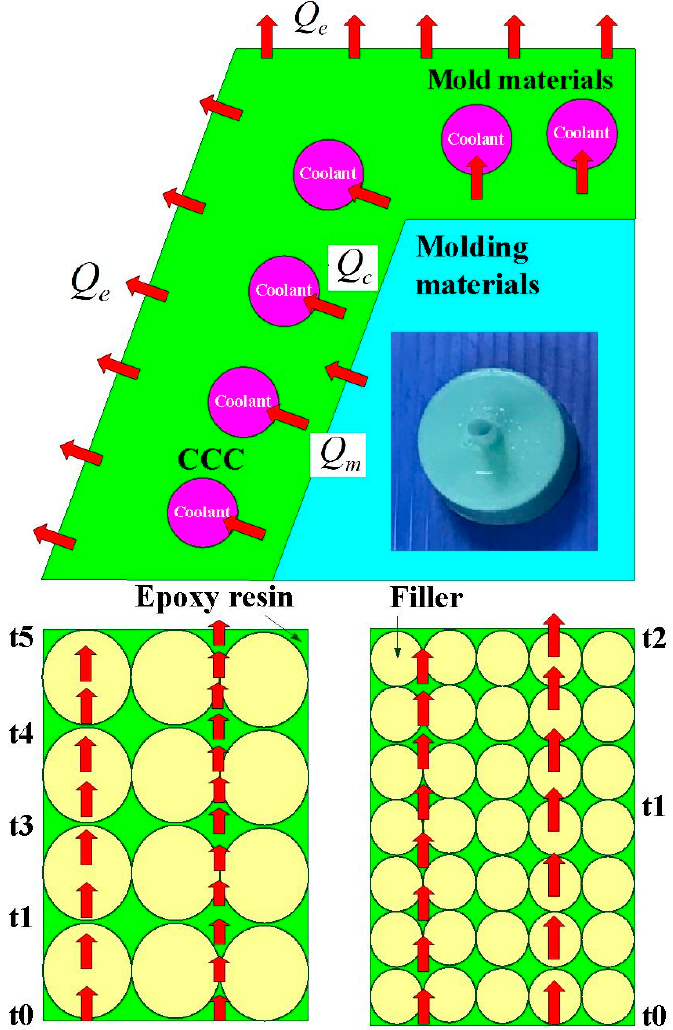
Figure 12. Schematic illustrations of heat conduction of the wax injection mold fabricated by epoxy resin filled with Cu powder with larger and smaller average particle sizes.